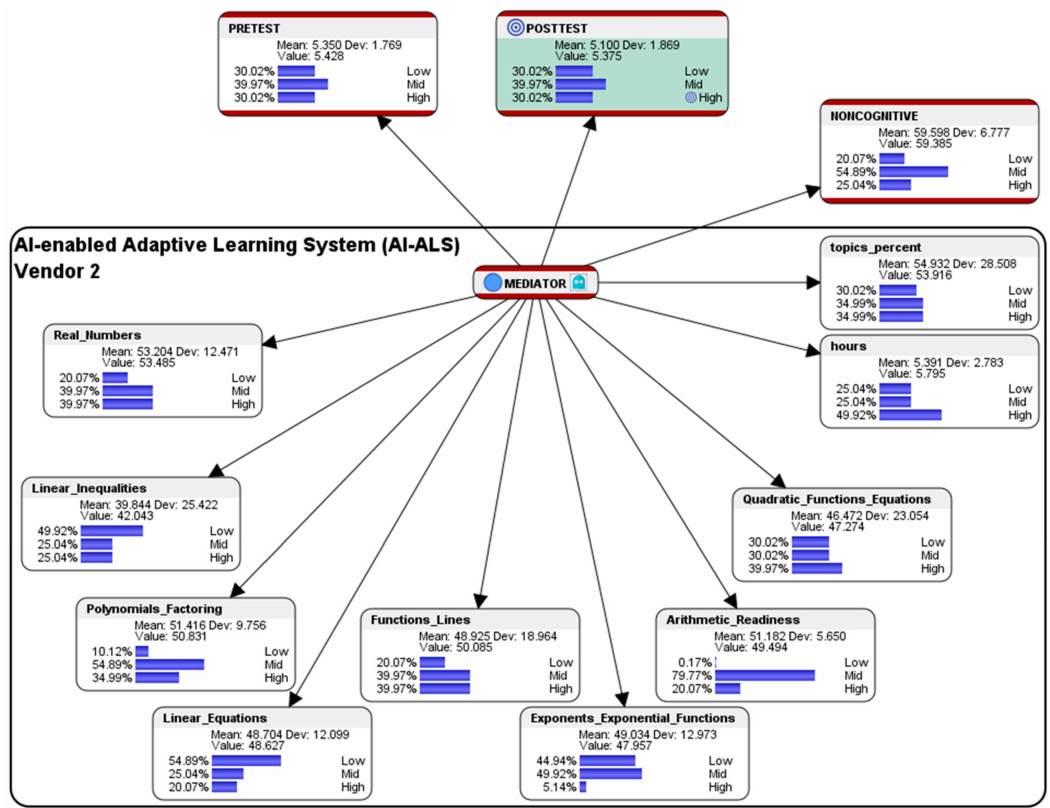
Figure 8. BN model of the students who had used the AI-ALS from Vendor 2 (N = 20 students). Visualization of the Performance of the Students Who Had Used Vendor 3